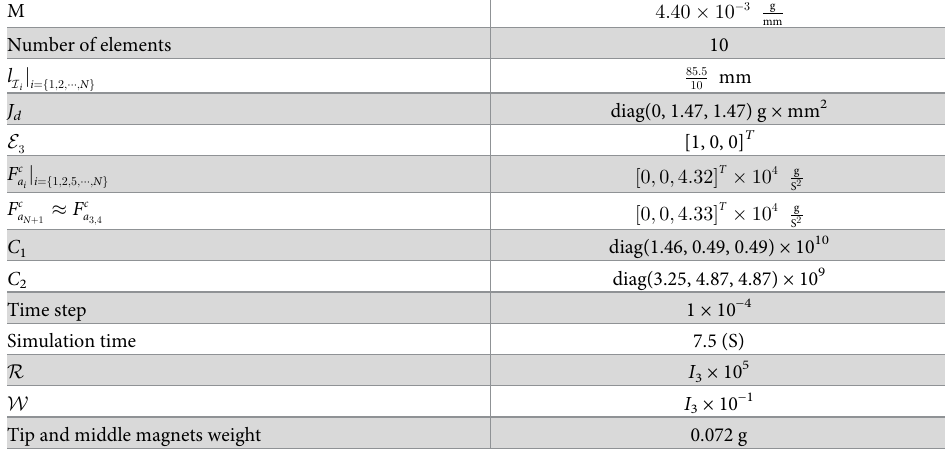
Table 7. Simulation parameters in Eqs (10)–(16)and (21) for in-plane experiment of square cross-section PDMS rod (with 2 magnets).